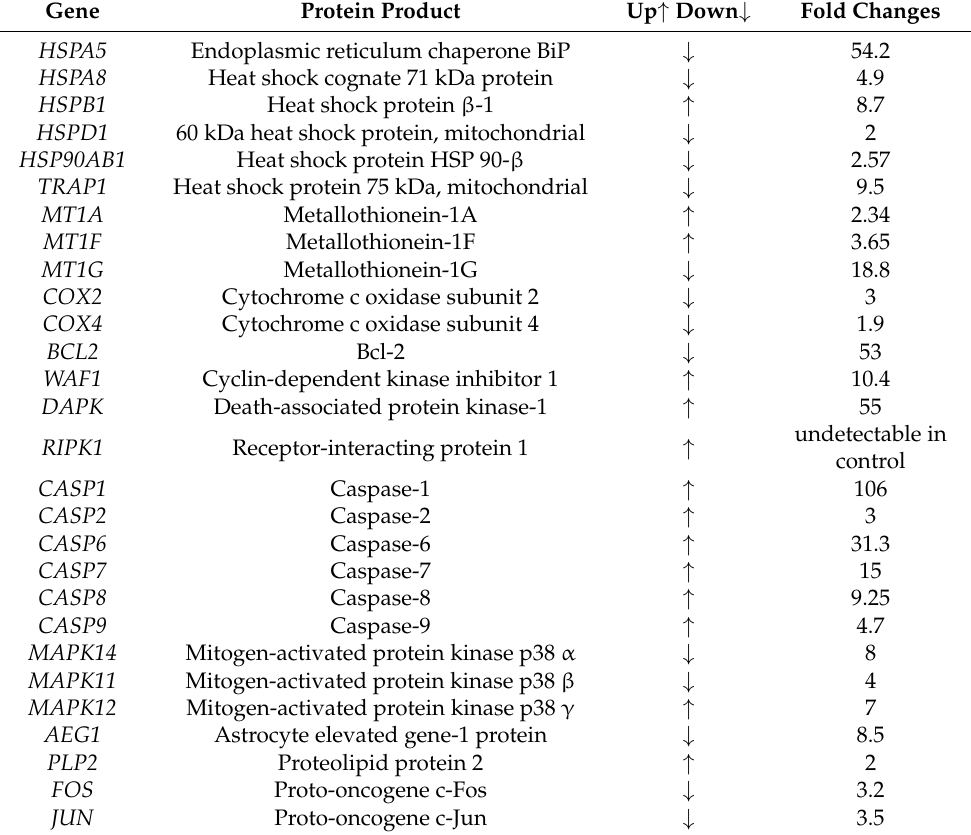
Table 1. Gene expression changes in MDA-MB231 breast cancer cells exposed to 5mM CdCl 2 for 96